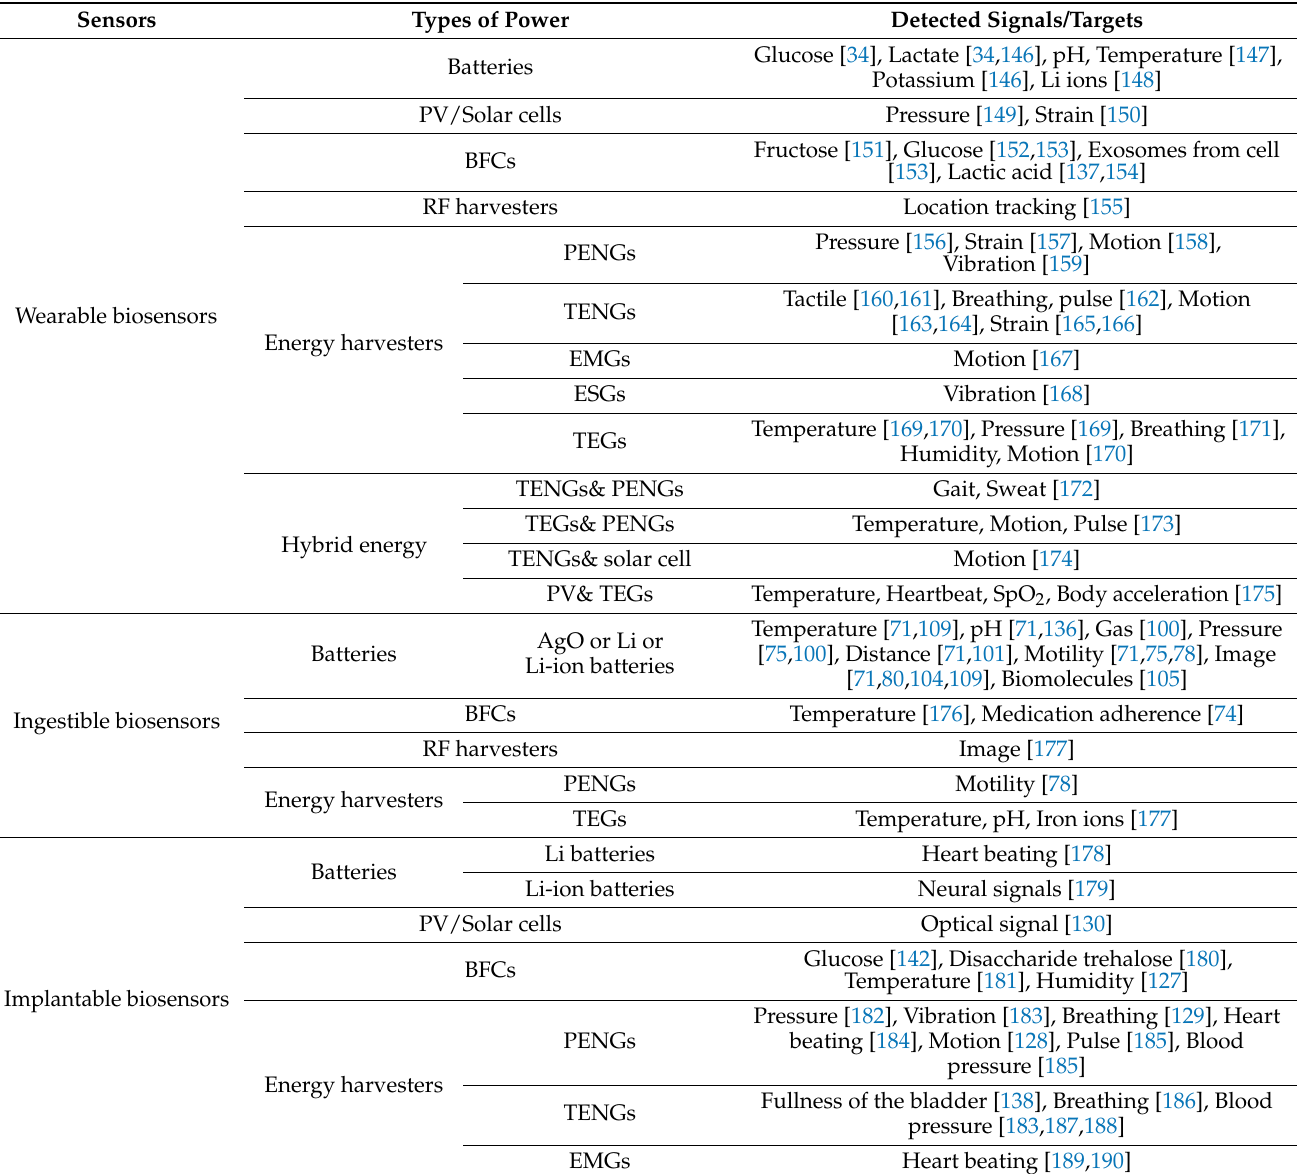
Table 5. Summary of power sources to three kinds of